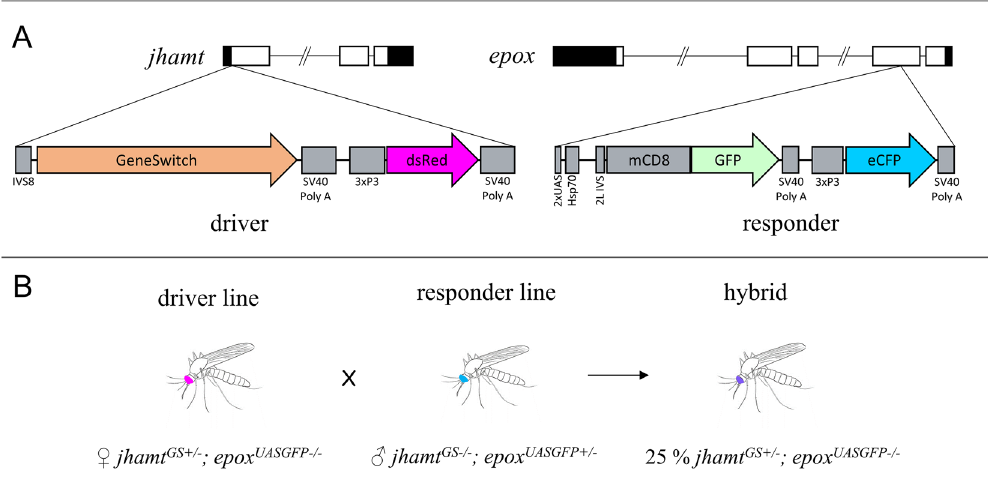
Figure 6. Development of an inducible GeneSwitch system. ( A ) Diagram of the driver and responder constructs. Driver: GenSwitch locus. dsRed (red eyes) was used as a selection marker under the control of 3xP3. The insert was surrounded by two 1.5 kb jhamt locus homologous arms to facilitate recombination. Responder: 2x UAS locus. GFP with a membrane localization signal (mCD8). eCFP (blue eyes) was used as a selection marker under the control of 3xP3. The insert was surrounded by two 1.5 kb epox locus homologous arms to facilitate recombination. ( B ) Crossing schemes to generate a hybrid. jhamt GS + /− females were crossed with epox UASGFP + /− males to generate hybrids containing both the effector and responder genes ( jhamt GS + /− ; epox UASGFP + /− ). Hybrids were used to test inducibility by RU486.